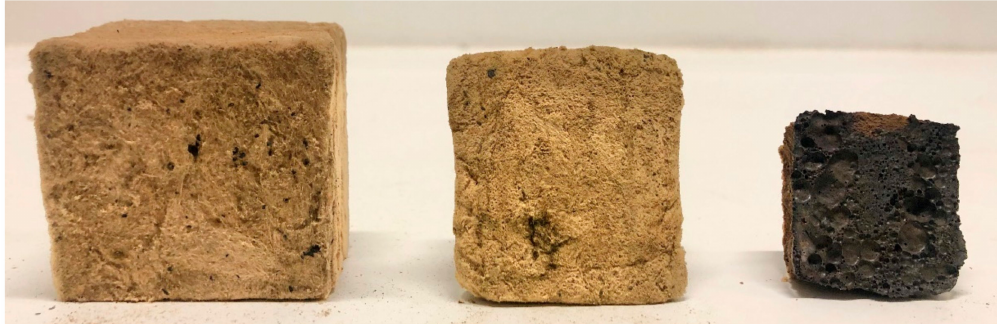
Figure 9. Test specimens after furnace heat treatments up to 1100 ◦ C (left), 1190 ◦ C (middle) and 1200 ◦ C (right), as seen from the bottom of the